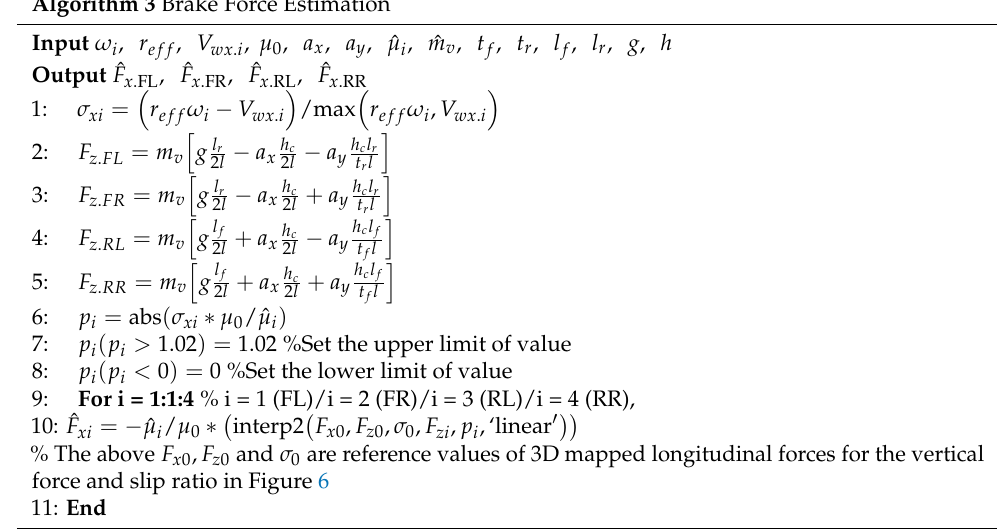
Algorithm 3 Brake Force